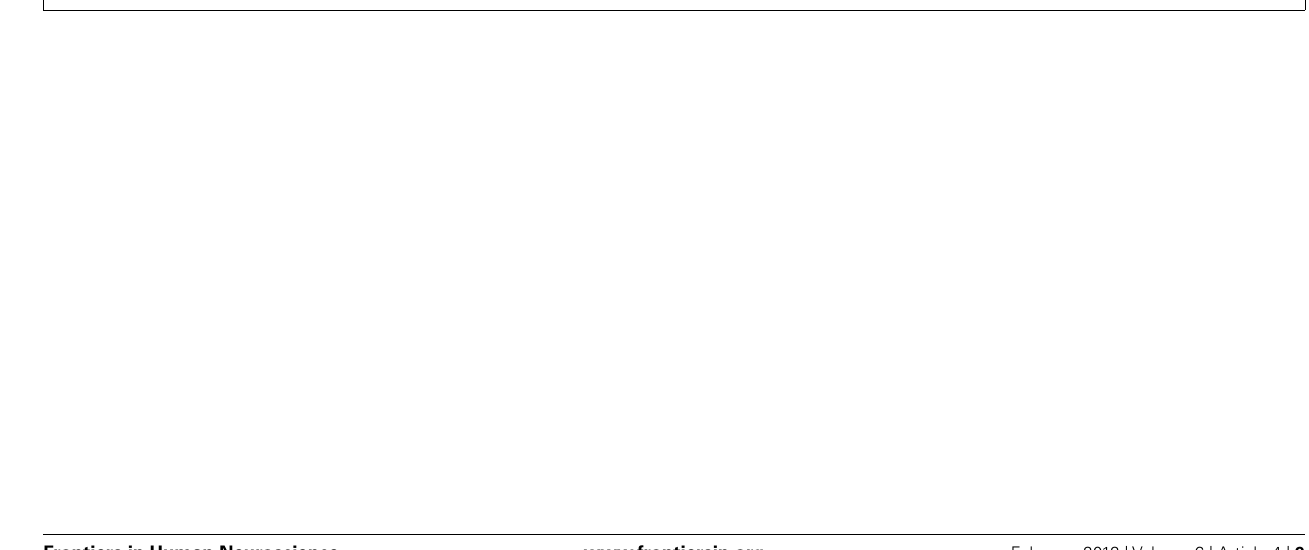
FIGUREA1 | Distribution of trustee’s money back transfers in the trust experiment. (A) Average back transfers in the GG group at each transfer and back transfer level. (B) Average back transfers in the AG/AA group at each transfer and back transfer level. MU, monetary